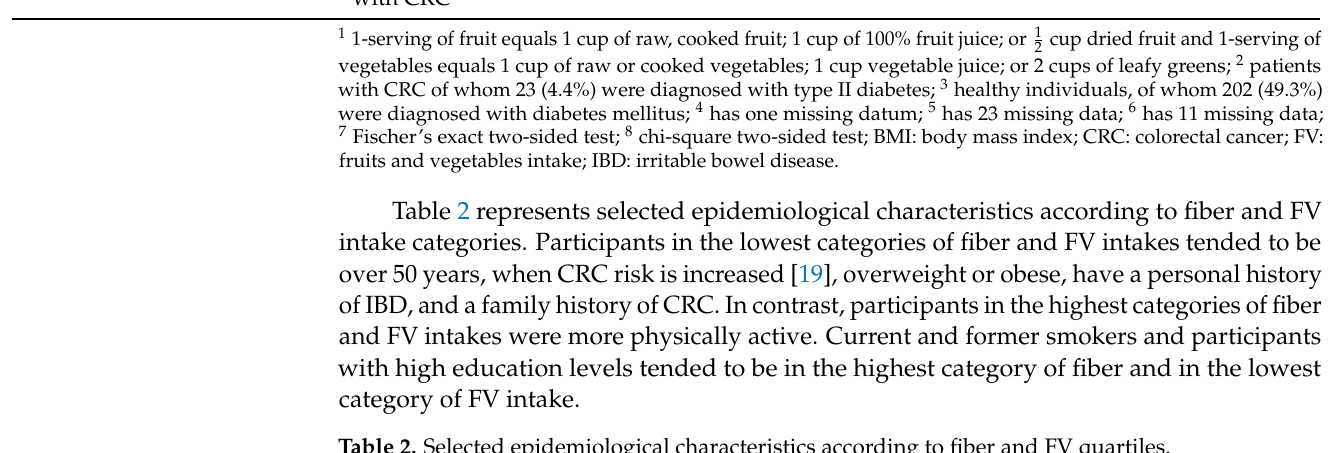
Table 2. Selected epidemiological characteristics according to fiber and FV